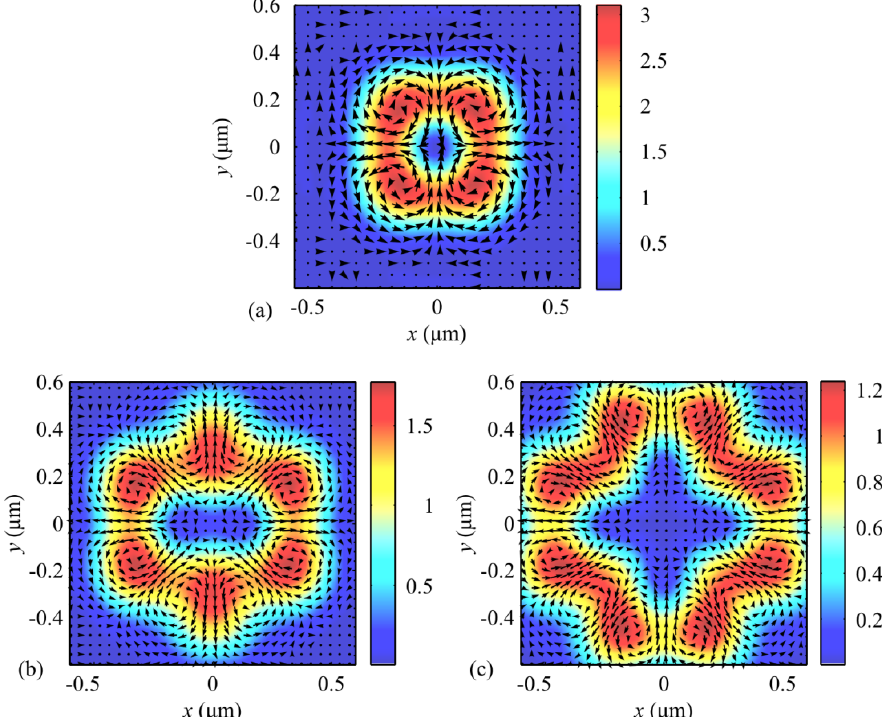
Figure 7. Intensity distribution and the magnitude and direction of the Poynting vector (arrows) in the focal plane when focusing a plane wave with the hybrid polarization of Equation (1) for ( a ) m = 1, ( b ) m = 2, and ( c ) m = 3.